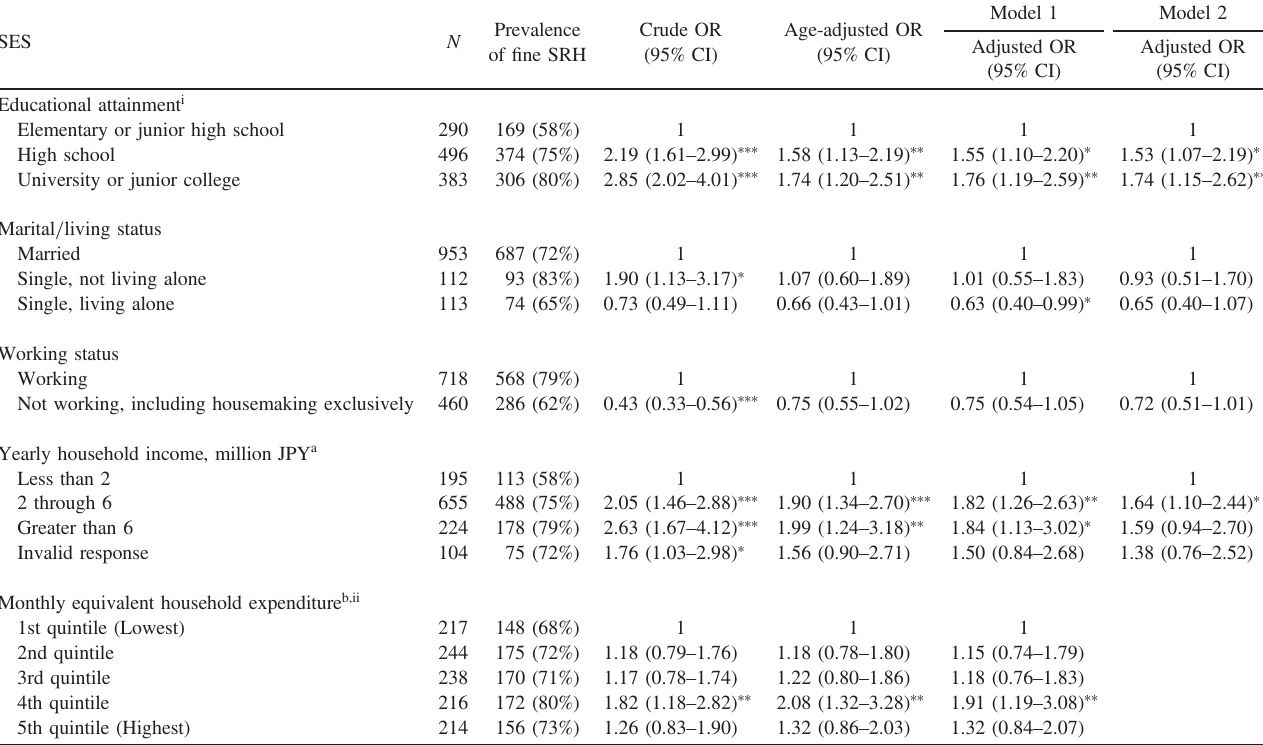
Table 2. Relationships among socioeconomic status and fi ne self-rated health in men ( n = 1,178): NIPPON